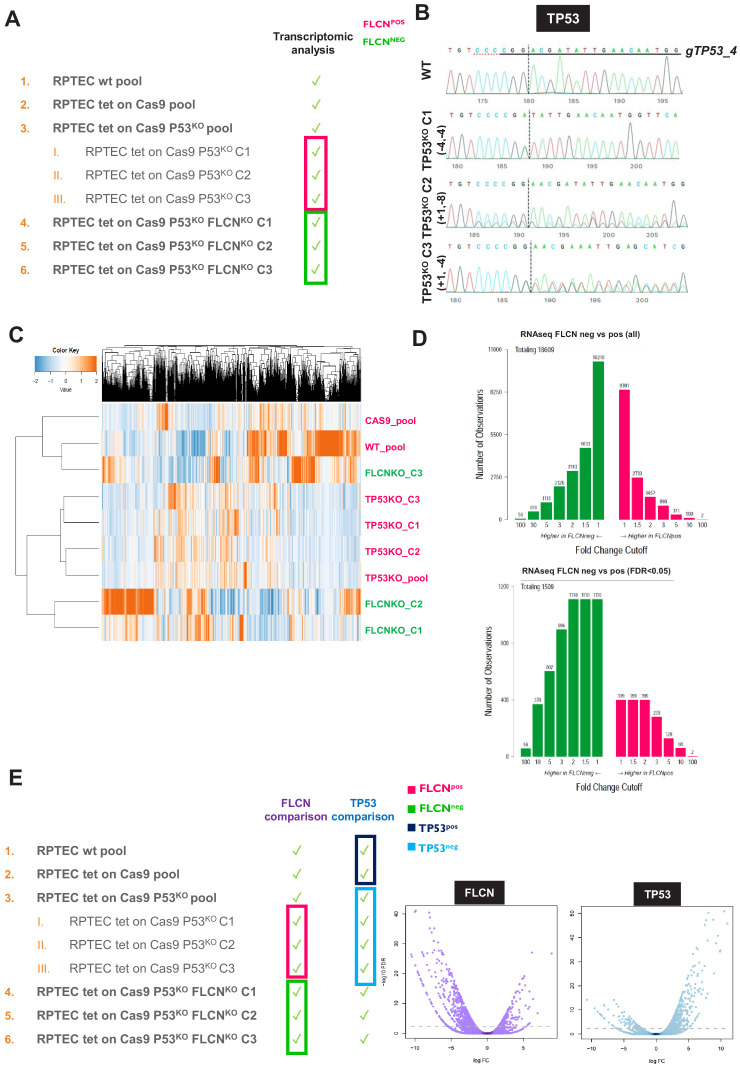
Comparative analyses of RPTEC FLCNPOS vs. FLCNNEG cell line pairs.(A) FLCNPOS and FLCNNEG RPTEC cell lines used for RNAseq. To correct for possible clonal effects on global transcription levels, three single-cell clones (C1, C2, and C3 respectively, derived from TP53KO pool) were added to the comparison. (B) Sanger sequence chromatogram of genomic DNA isolated from TP53KO single cell line clones C1, C2, and C3. Indel analysis was performed with the Synthego CRISPR Editing (ICE) tool. (C) Unsupervised hierarchical clustering of all genes identified in RNAseq experiment of FLCNPOS vs. FLCNNEG RPTEC cell lines (TMM-normalized values). (D) Numbers of (significant, FDR < 0.05) differential genes observed in FLCNNEG and FLCNPOS RPTECs, ranked by fold change. (E) Overview of comparisons made for differential expression analyses. The purple volcano plot represents the FLCNPOS vs. FLCNNEG comparison and shows that most significant differentially expressed mRNAs are upregulated in FLCNNEG cells, identifying FLCN as a transcriptional suppressor. The blue volcano represents the TP53POS vs. TP53NEG analysis and shows, for comparison, that loss of the transcriptional activator TP53 reduces expression of the most significant differentially expressed mRNAs. Statistical details can be found in the Materials and methods section.